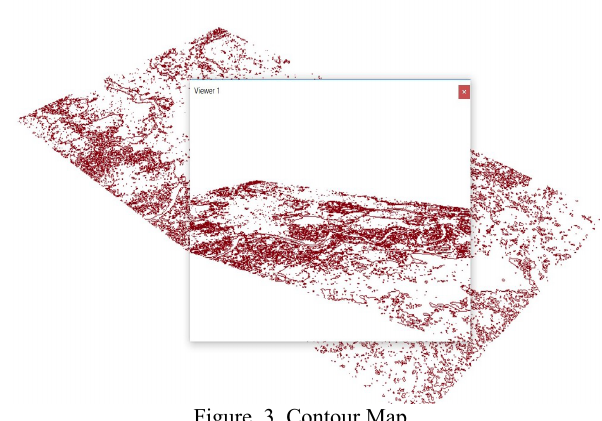
Figure.5. Watershed overlay on Google Earth